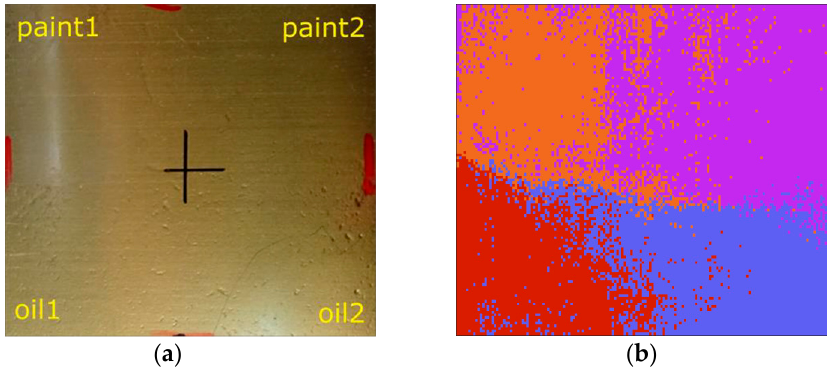
Figure 2. ( a ) Visible image of the oil and paint samples deposited in 4 areas on a metal plate. The cross indicates the center where all samples are tangent; ( b ) Generated false-color image using a classification algorithm.